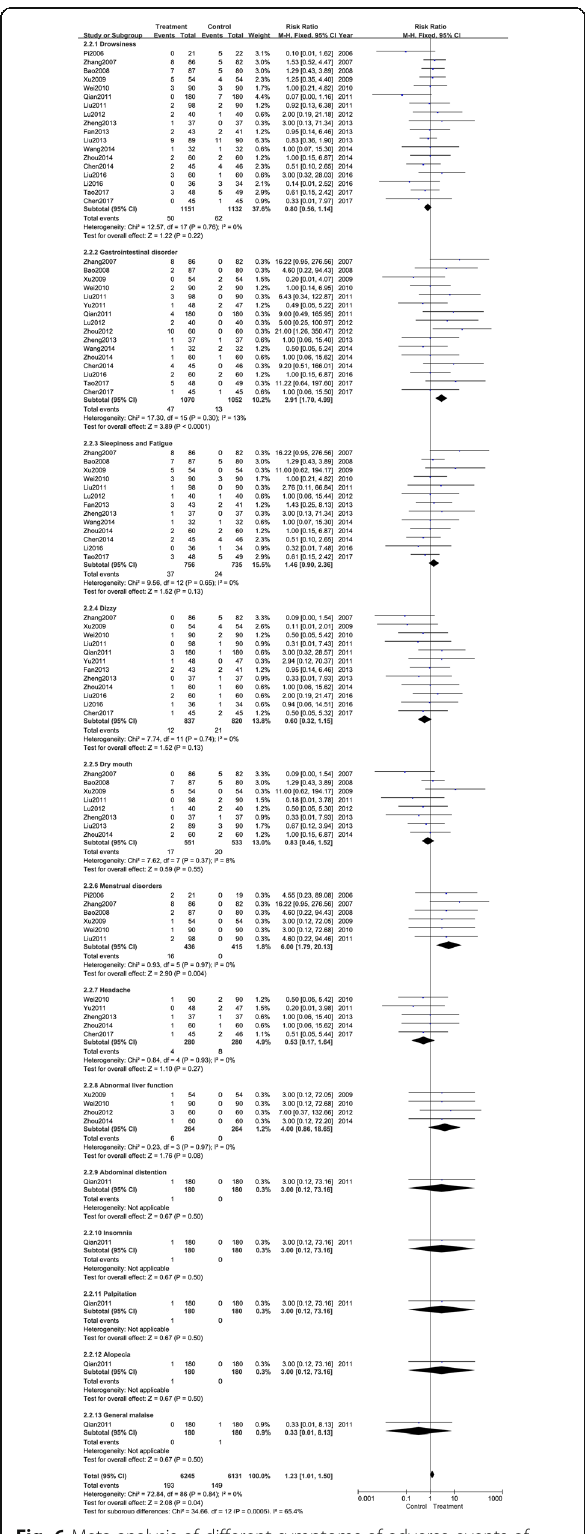
Fig. 6 Meta-analysis of different symptoms of adverse events of Tripterygium preparations combined with antihistamines versus antihistamine. CI indicates confidence